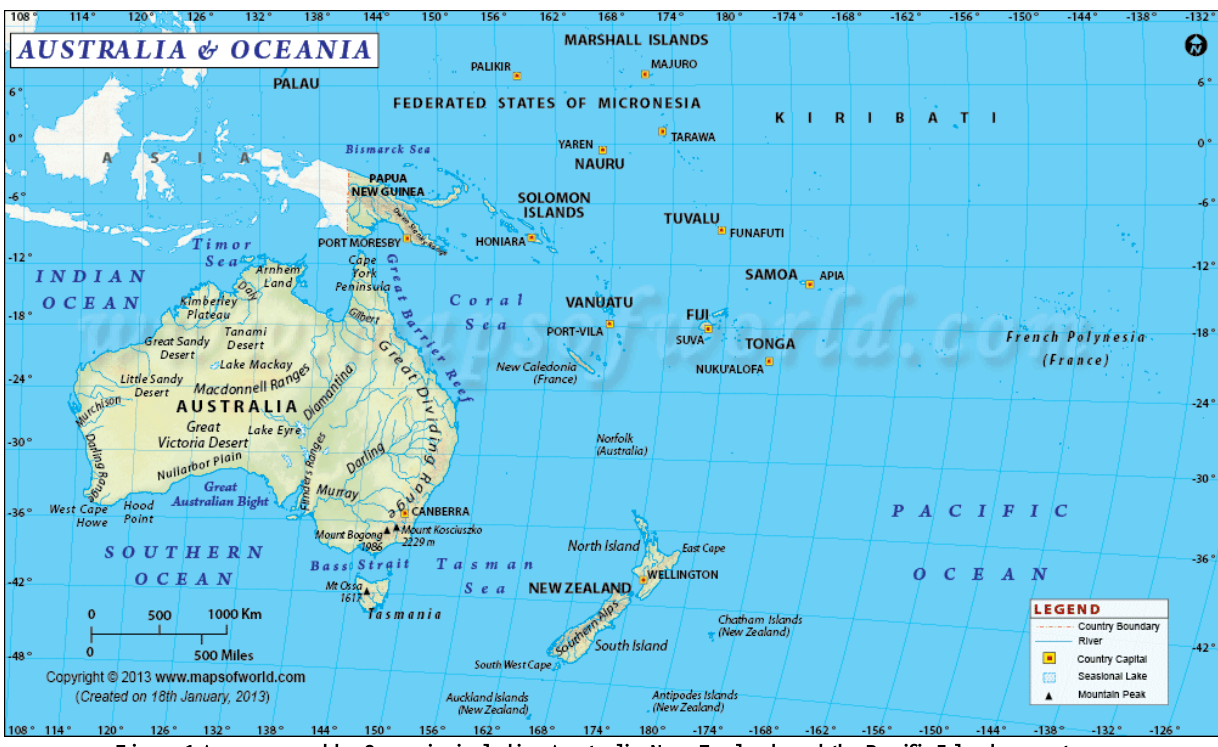
Figure 1 Area covered by Oceania, including Australia, New Zealand, and the Pacific Islands, courtesy WWW.mapsoftheworld.com